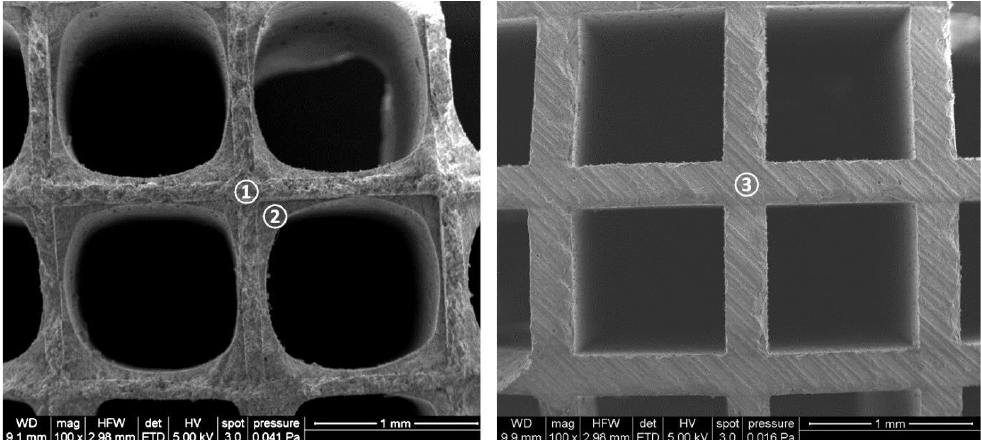
Figure 1. Scanning electron microscope image of an exemplary catalytic converter consisting of: ① a ceramic carrier; and ② washcoat layer; versus a ③ fully extruded converter.